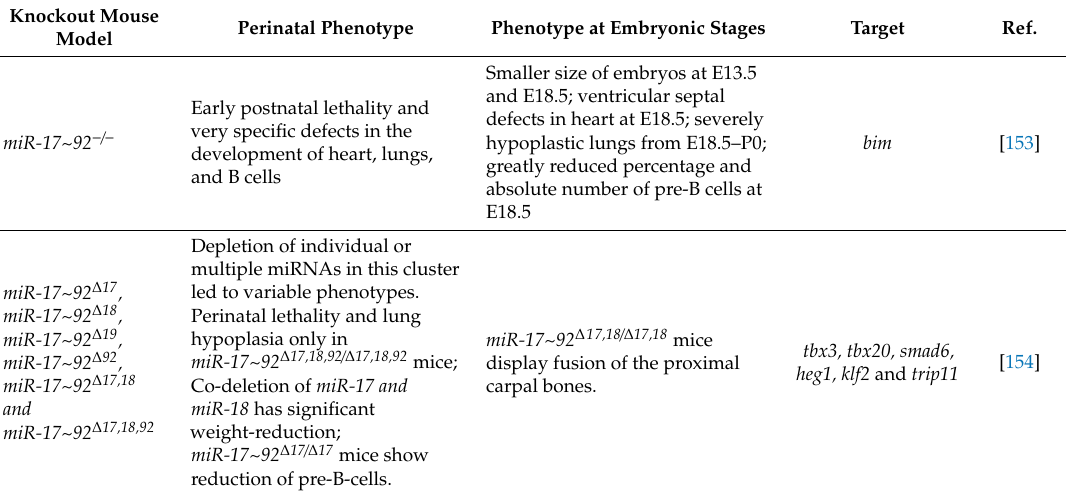
Table 1. Studies of specific miRNAs in knockout mouse